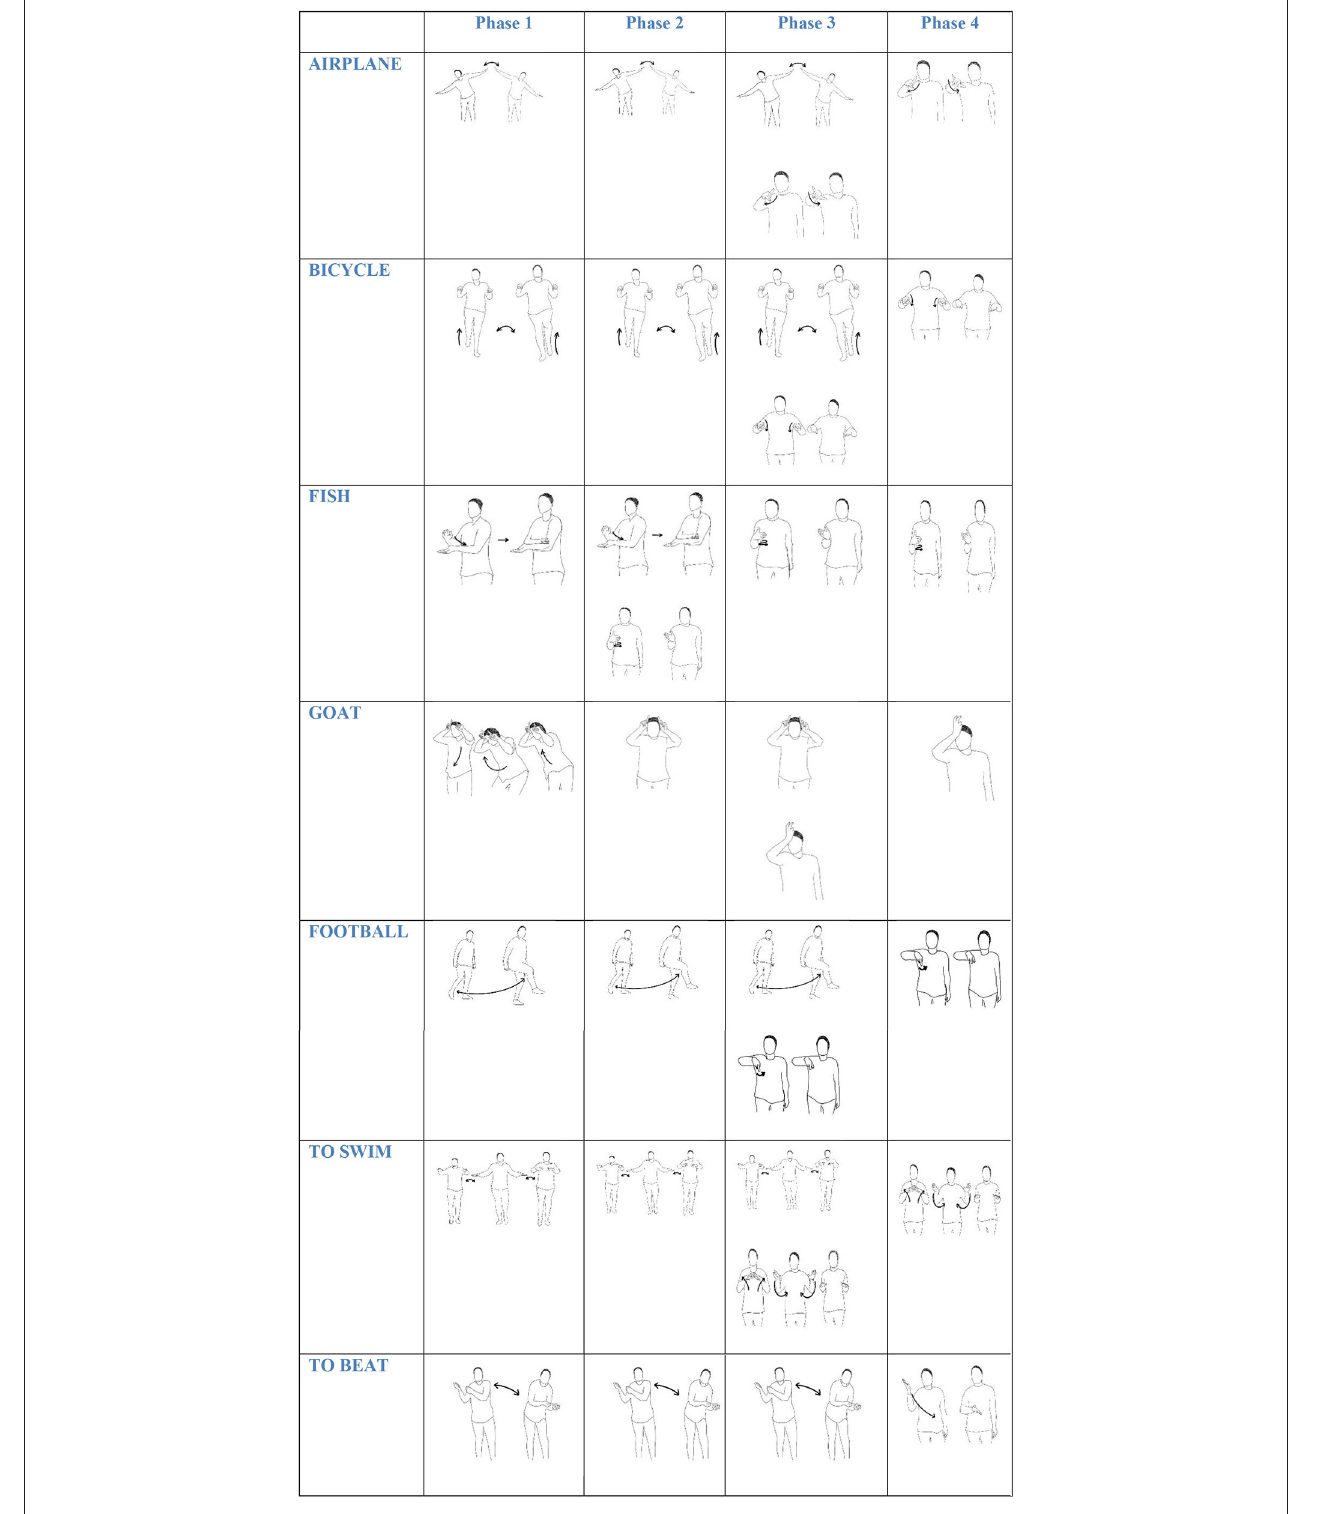
FIGURE 2 | Pantomimic gestures and signs across the four